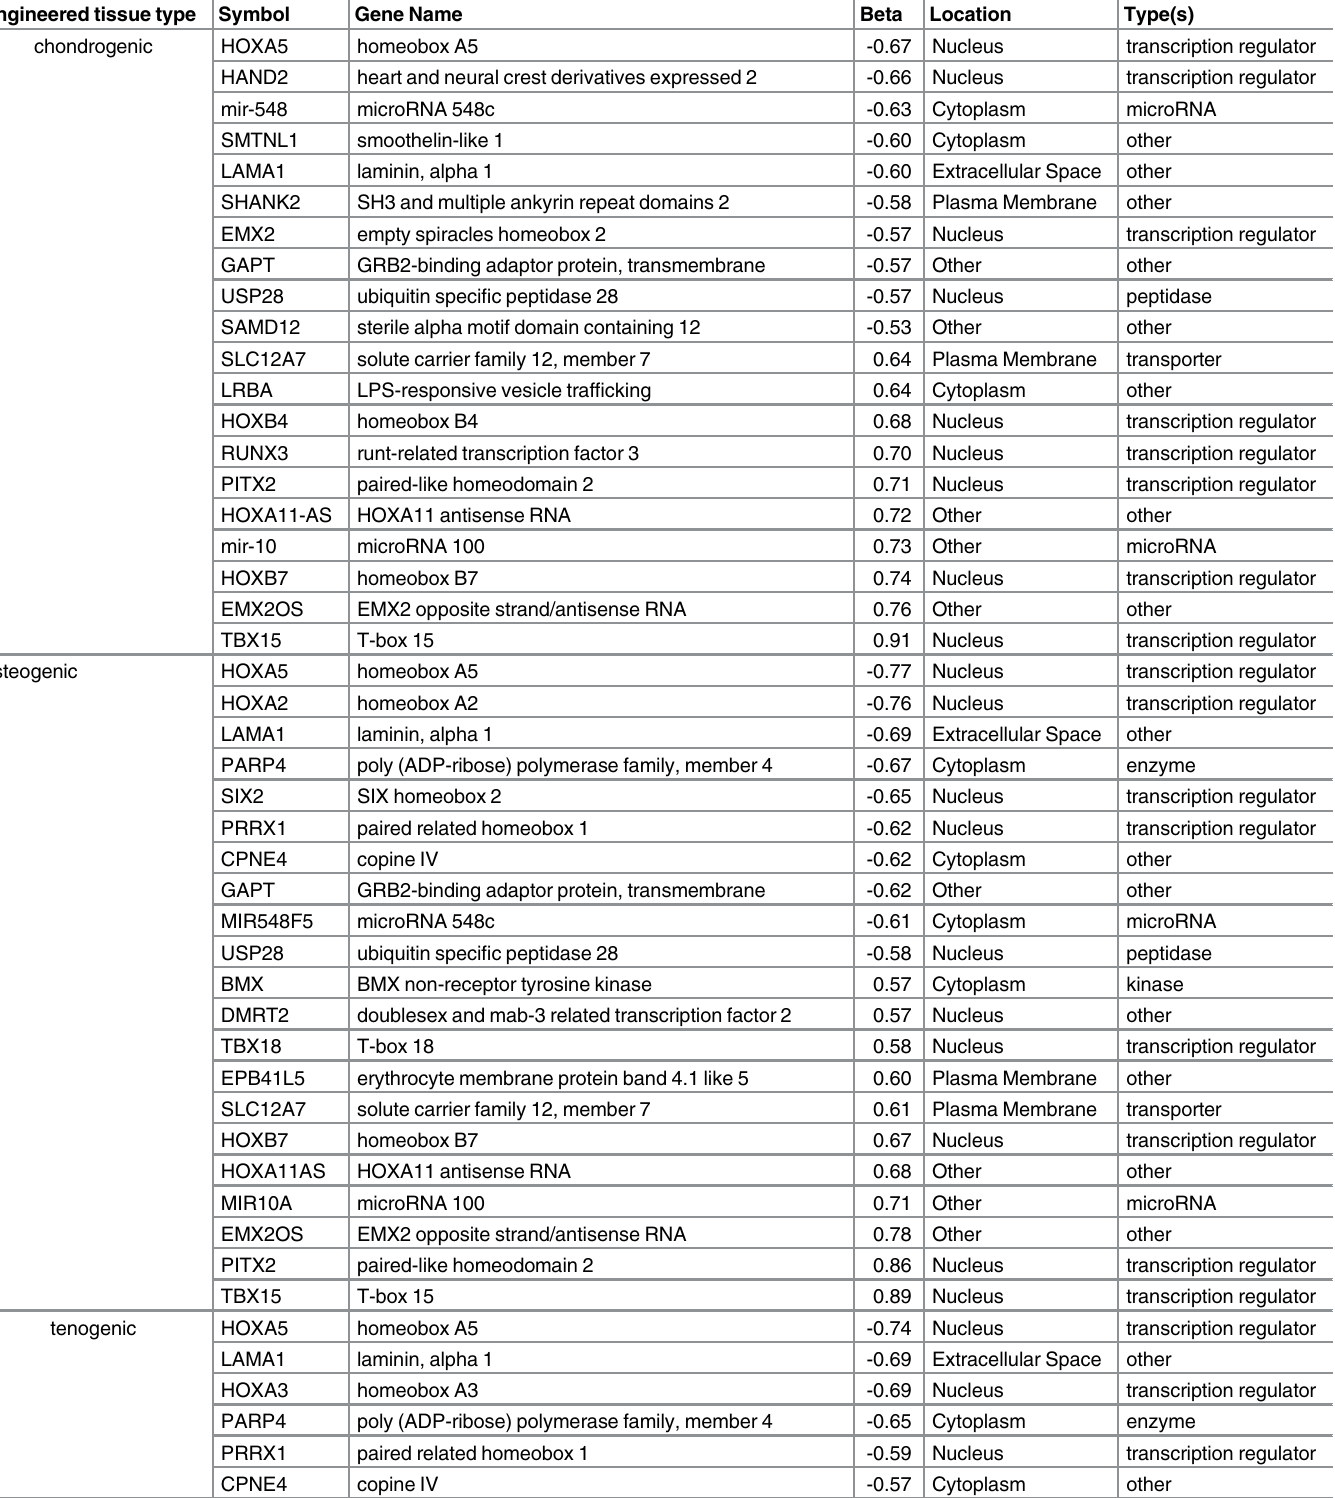
Table 8. Top 10 annotated genes with increased and decreased